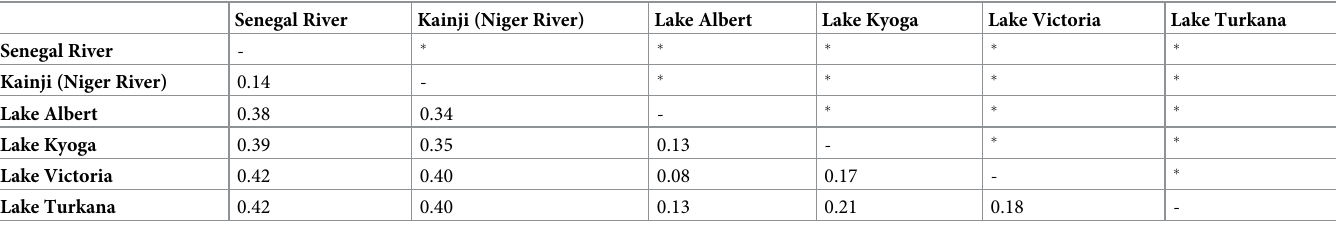
Table 3. Estimates of pairwise F ST between six Nile perch populations.